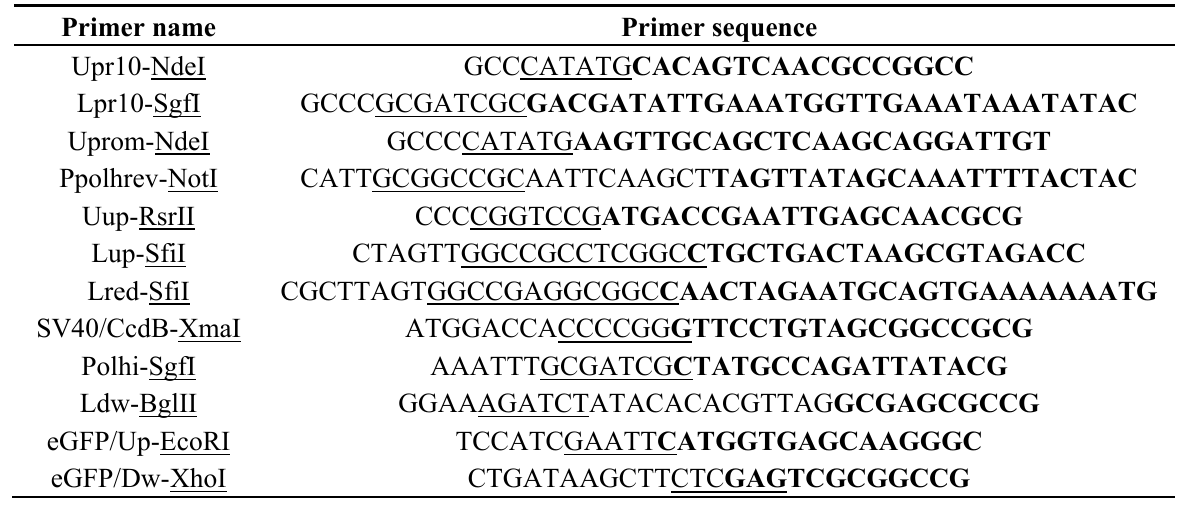
Table 1. Primers used to generate the transfer vectors pAg-I Ppo I and pI3. Relevant restriction sites incorporated in the primers are underlined and the nucleotides that anneal with the template are highlighted in